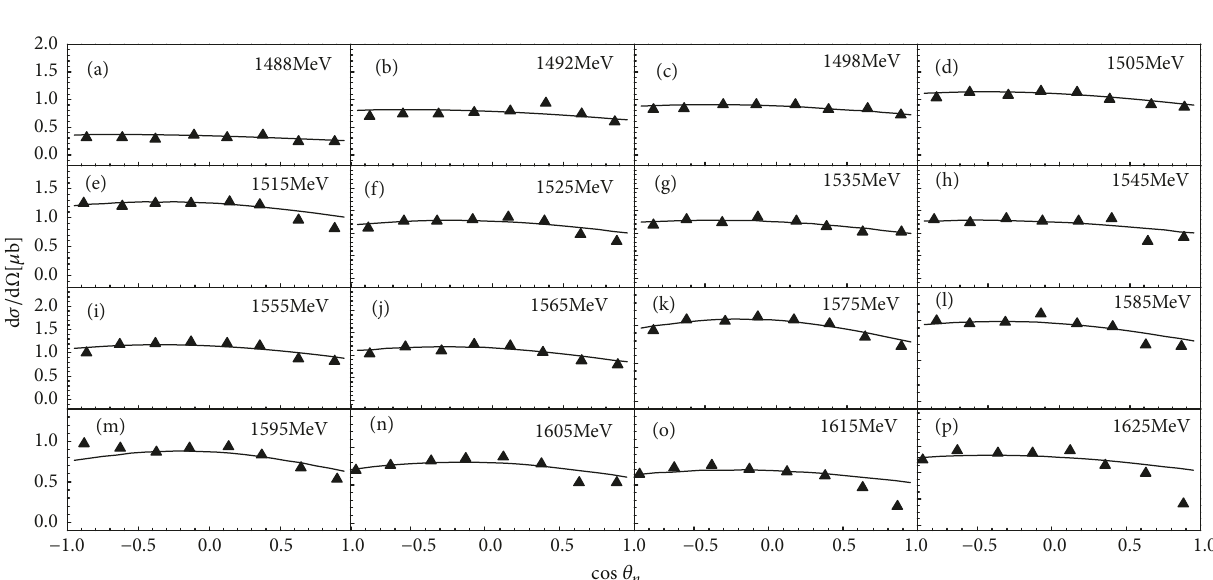
Figure 4: Angular distributions in the 𝜂 -nucleon cm system for the reaction 𝛾𝑝 󳨀→ 𝑝𝜂 for the different bins of final state energy 1488 MeV ≤ 𝑊 ≤ 1625 MeV. The symbols represent the experimental data from the CBELSA/TAPS detector at the electron accelerator ELSA in Bonn [9]. The results in the multisource thermal model are shown with the